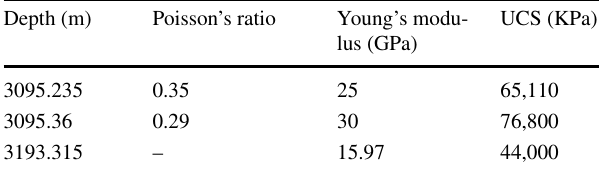
Table 3 Core laboratory results (Gachsaran formation) Depth (m)